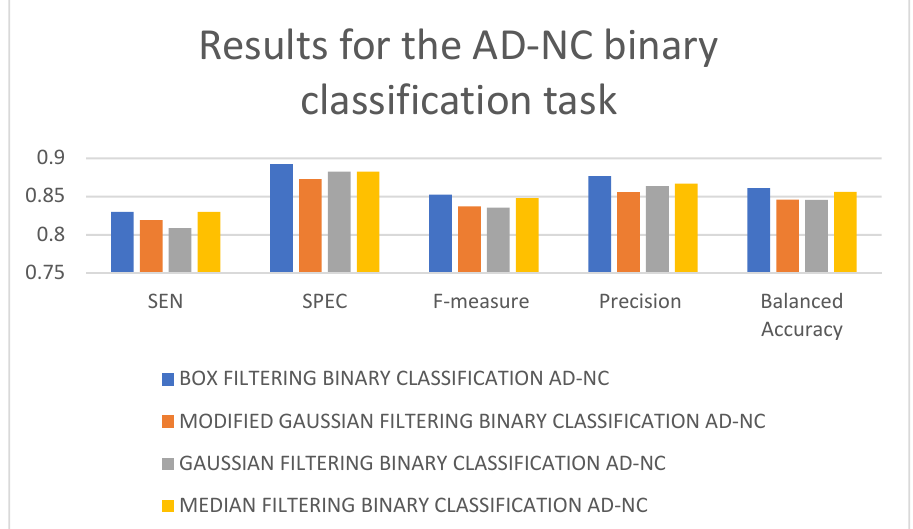
Figure 7. Results of different 3D-CNN architectures for the AD-NC binary classification task.